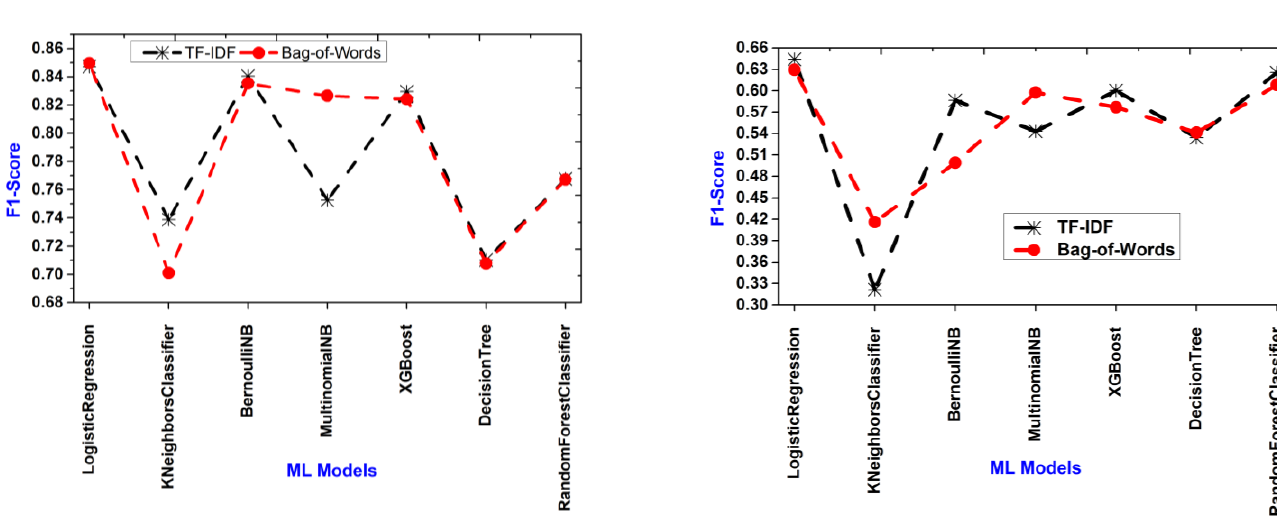
Fig. 3. F1-score for a dataset (Flipkart Reviews) using seven ML algorithms with TF-IDF and bag of words